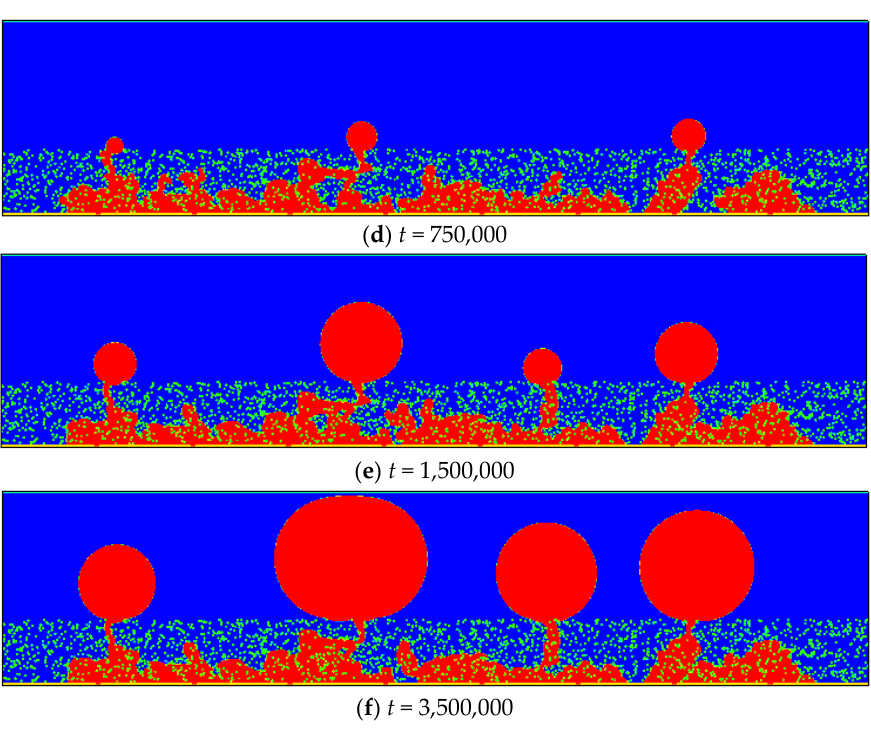
Figure 7. Time evolutions of liquid water distribution in the domain with eight fractures.